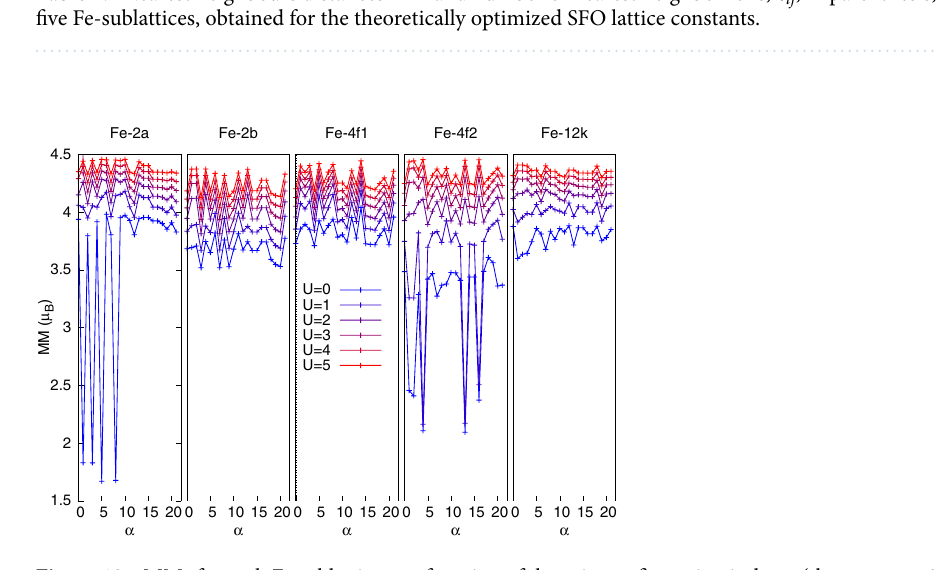
Figure 10. MMs for each Fe sublattice as a function of the spin configuration index α (the case α = 0 corresponds to the ground state). Each color corresponds to a different value of U, as indicated in the legend in eV. The MMs in sublattices 2 a and 4 f 2 attain anomalously small values (low spin states) when U ≤ 1 eV at some specific spin